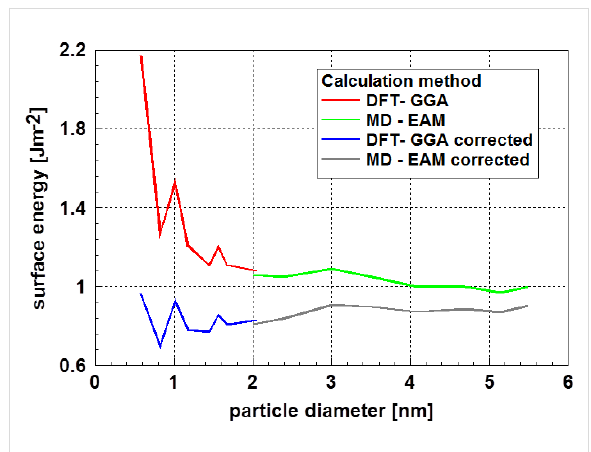
Figure 16: Surface energy of silver particles as function of the particle diameter [49]. This graph shows the original values and those corrected according to Holec et al. [53]. Except the systematic varia- tion in the values for particles with sizes below ca. 2 nm, it is remark- able that there is only a relatively small influence of the particle diame- ter on the surface